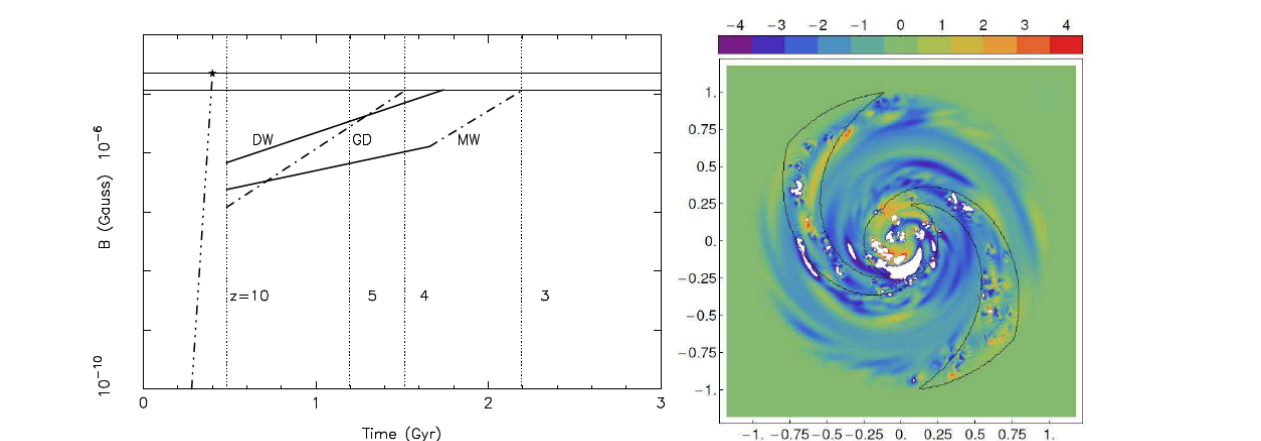
Figure 5. ( Left ) Evolution of magnetic field strength in dwarf galaxies (DG), Milky-Way-type galaxies (MW), and in giant disk galaxies (GD). The thick dashed-dot-dot line shows the evolution of the small-scale magnetic field generated by the small-scale dynamo. The evolution of the large-scale magnetic field generated by the α Ω dynamo in quasi-spherical galaxies are shown by the thick solid − line and that in thin-disk galaxies as thick dashed-dot dashed lines [46]. ( Right ) Color coded image of the modeled azimuthal magnetic field strength in the disk of a spiral galaxy with turbulent magnetic field injection assumed within the normal spiral arm regions as indicated by the thin black lines after 13.2 Gyr. The field strength is given in µ G